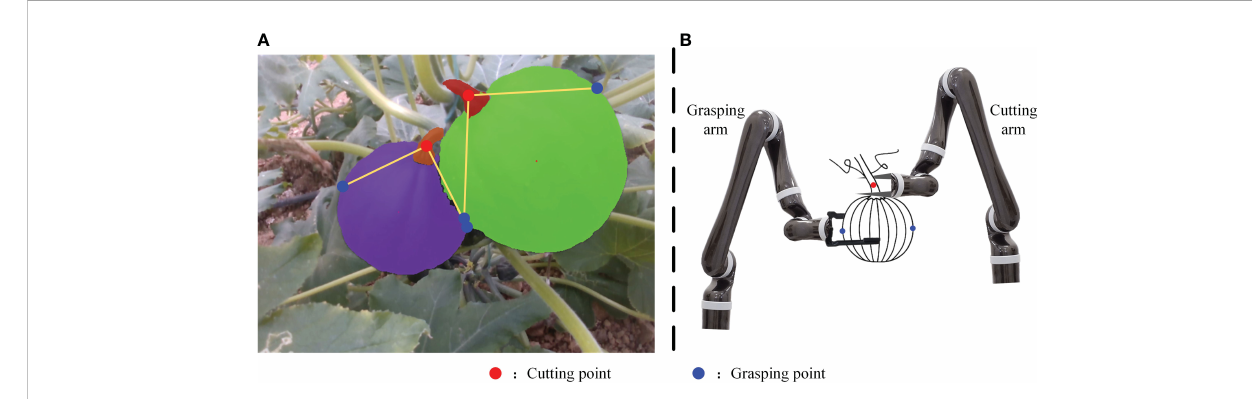
FIGURE 1 Example of pumpkin keypoint detection framework output (A) and pumpkin picking illustration (B)